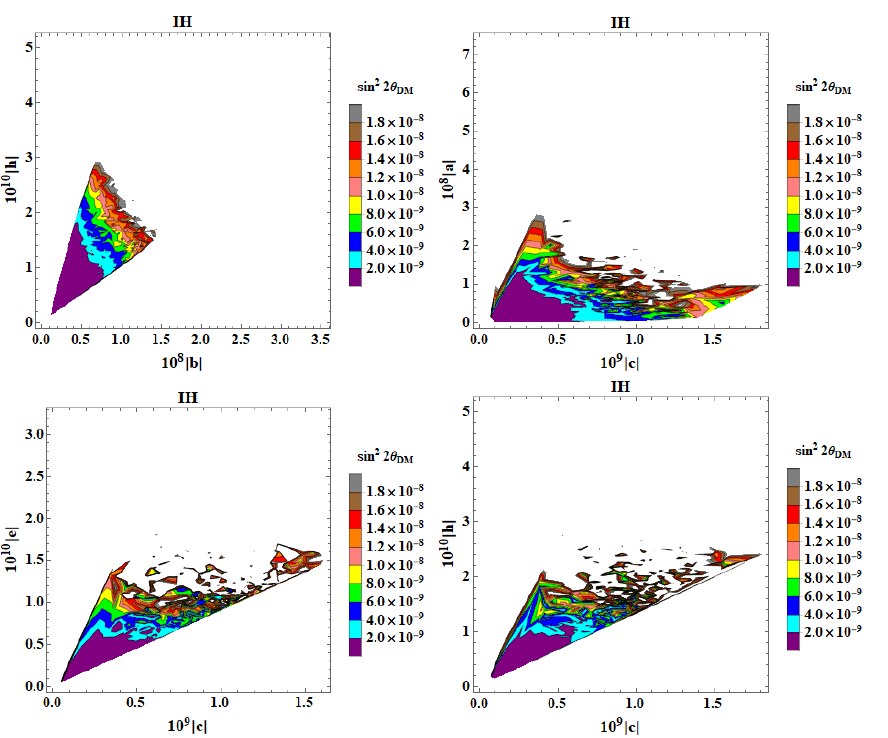
Figure 14 . Variation of di(cid:11)erent model parameters (in eV) with the DM-active mixing as the contour for inverted hierarchy. The limit as predicted by cosmology is (10 (cid:0) 12 (cid:0) 10 (cid:0) 8 ).